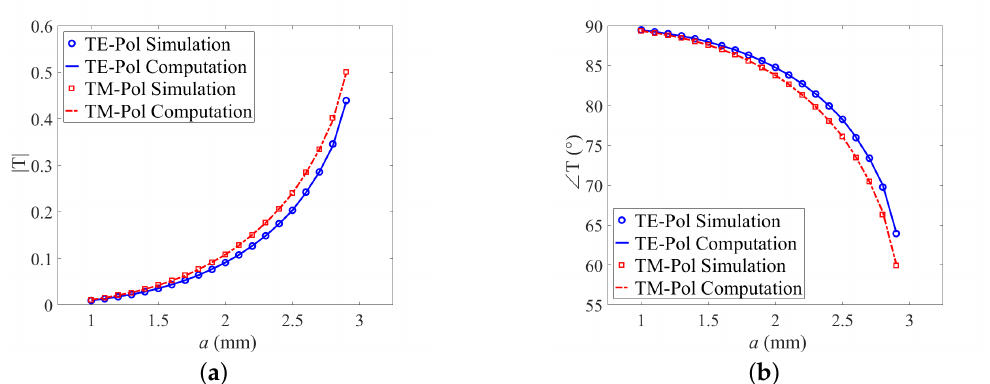
Figure 17. Comparison between simulated and computed transmission coefficients with θ = 45 ◦ of the zero-thickness PEC metascreen shown in Figure 15a: ( a ) magnitude ( b )